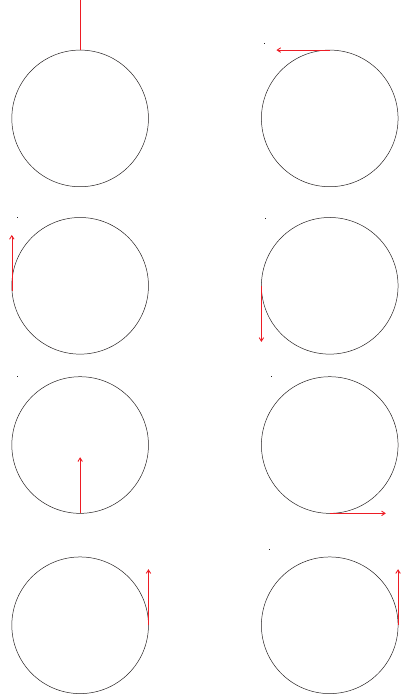
Figure 8. Examples of parallel transports. The figure illustrates two examples of parallel transports under Levi–Civita connections on four sampling positions. The transport on the left side is given by the metric ds 2 “ dr 2 ` r 2 d θ 2 . The transport on the right side is given by the metric ds 2 “ dr 2 ` d θ 2